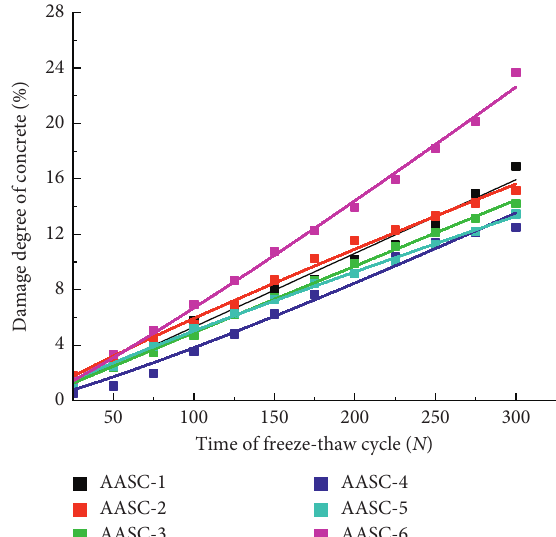
Figure 17: Relative dynamic elastic modulus accumulative damage power function